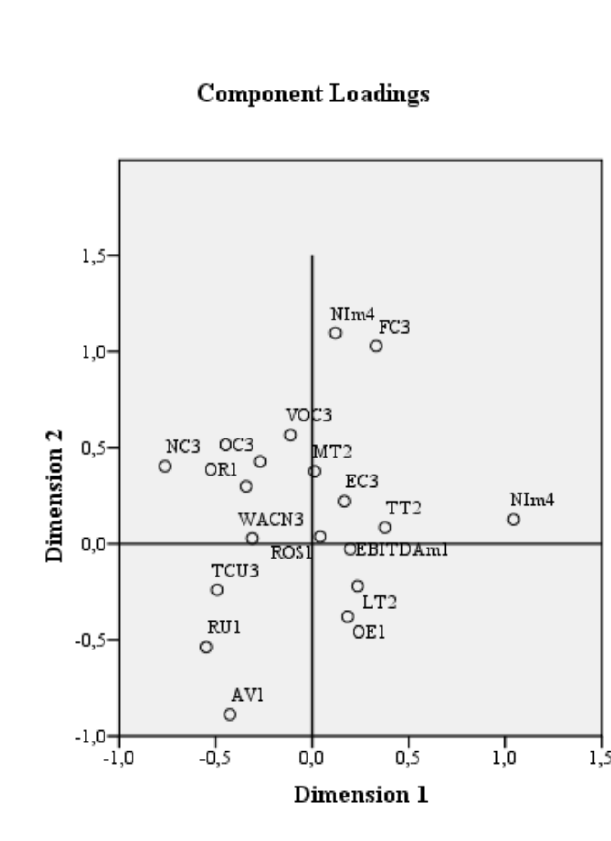
Figure 3. “Component Loadings 2007 (Ordinal and Multiple